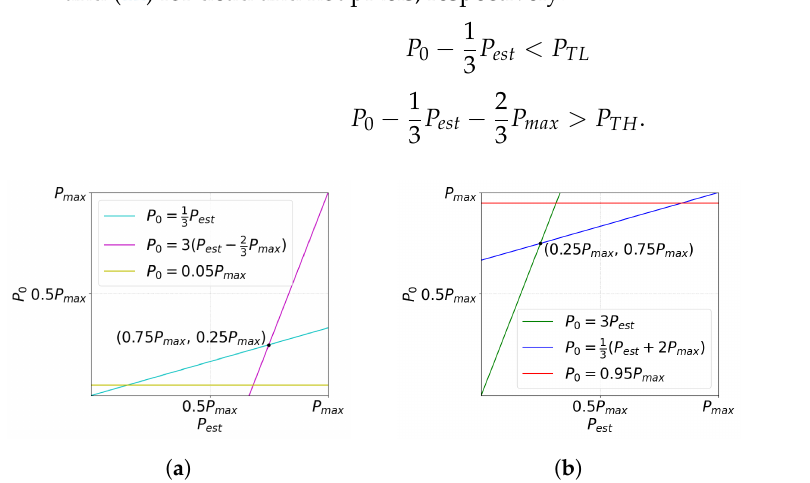
Figure 2. Detecting dead and hot pixels using Equations (6)–(9): ( a ) Dead pixels: Equations (6) and (7). When P est < 0.05 P max and Equation (6) is true, Equation (7) is true. ( b ) Hot pixels: Equations (8) and (9). When P est > 0.95 P max and Equation (9) is true, Equation (8) is true.